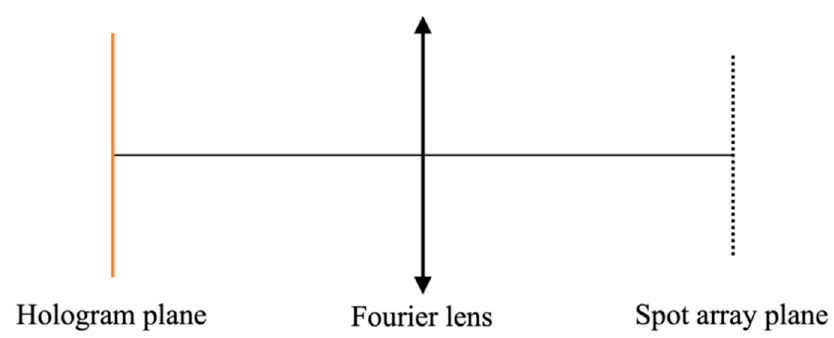
Figure 4. Optical setup for the simulation.